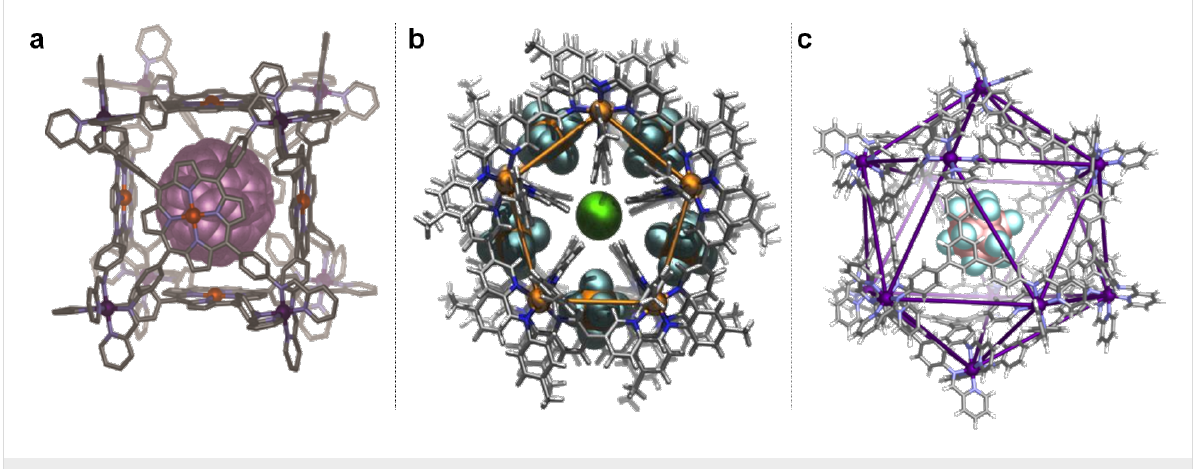
Figure 2: a) A cubic cage [26]; b) a pentagonal prism [27]; c) a pseudo- icosahedron